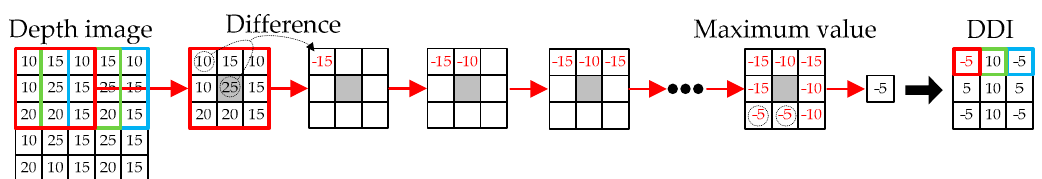
Figure 4. Example of DDI (Depth difference image).